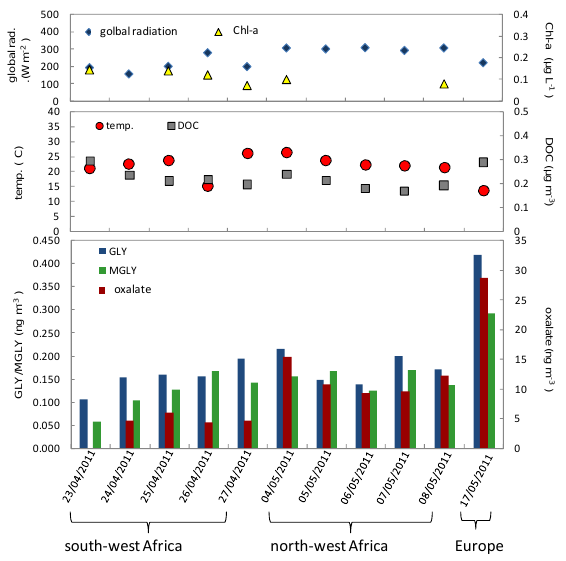
Fig. 4. Concentration of GLY, MGLY and oxalate together with DOC and environmental